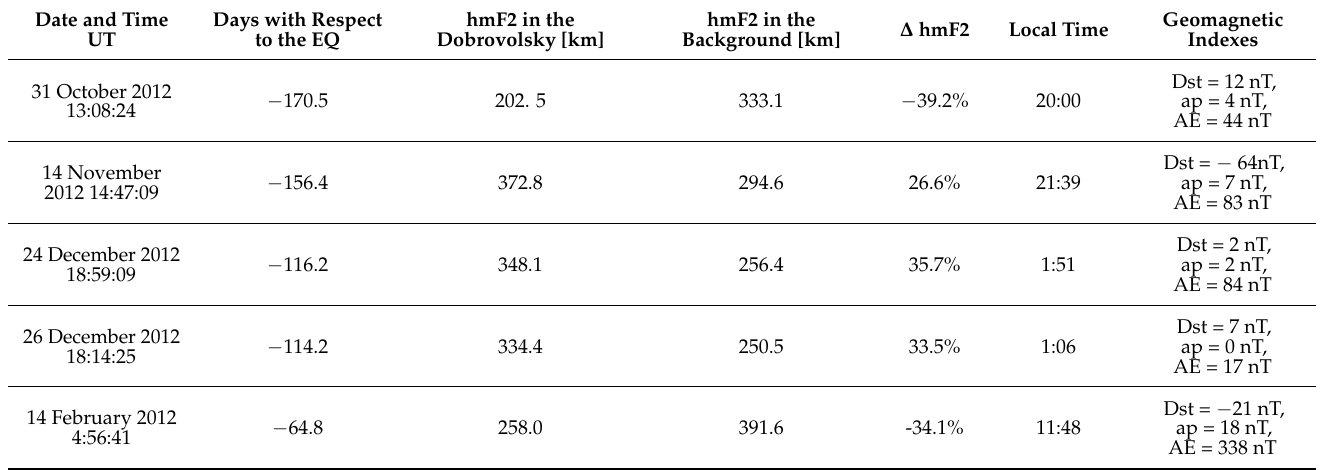
Table 1. Anomalous values of the F2 ionospheric peak as extracted from the time series shown in Figure 21. In the first rows, the anomalous altitude days of the F2 peak are presented, and in the following rows, the anomalous days for an increase in electron density in the F2 peak are listed.